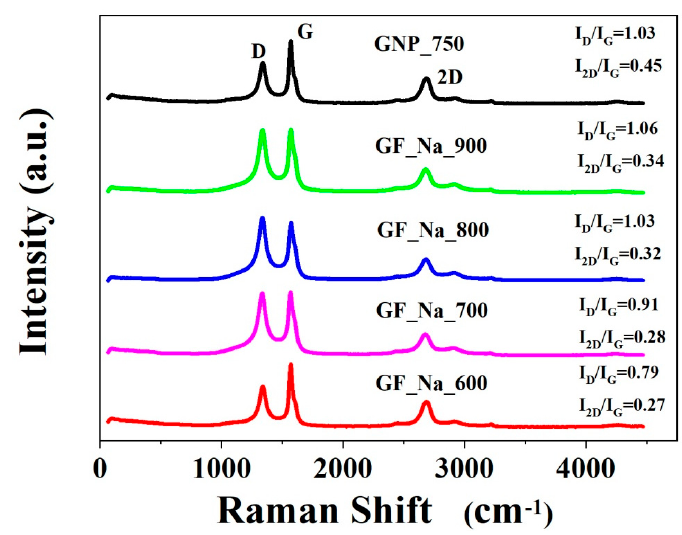
Figure 4. Raman spectra of obtained materials. Table 3. Results of Raman spectra and D, G, and 2D band data for obtained materials.